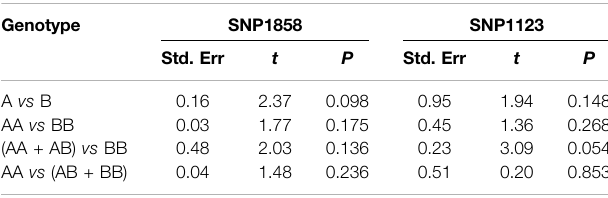
TABLE 5 | Publication bias analysis of PTPN22 gene SNP1858 and SNP1123 polymorphism and ITP